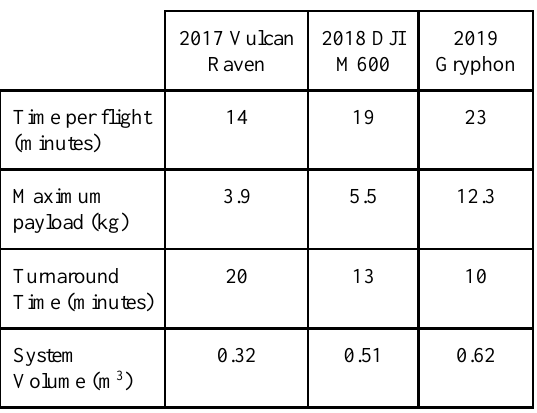
Table 1. Aircraft specifications for 2018 and 2018 field campaigns in Alaska. Details of an aircraft procured in 2019 shown for comparison. System volume includes rugged hard cases for airframe and